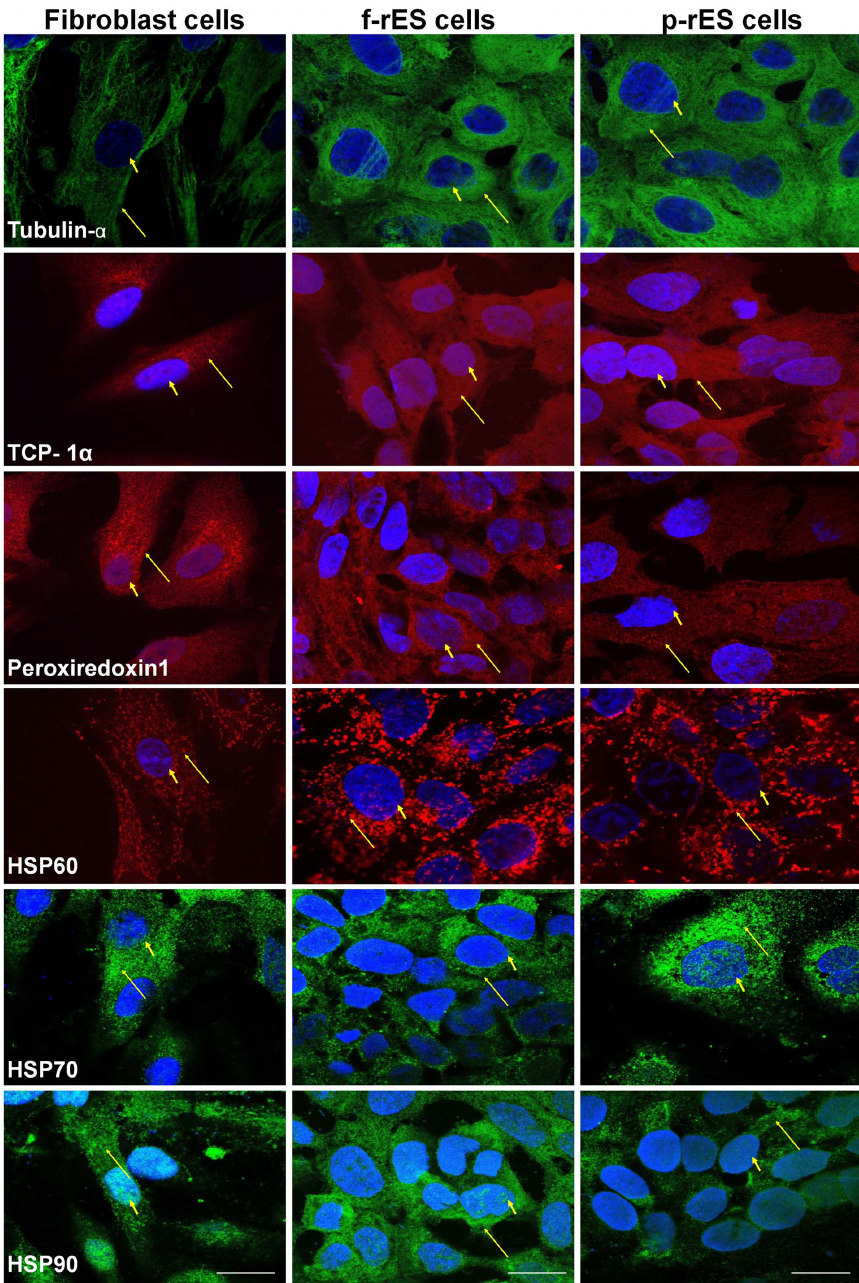
Figure 8. Immunocytochemical confirmation and subcellular localization of the selected proteins in fibroblast, f-rES, and p-rES cells. The cells were hybridized with primary antibodies against a -tubulin, peroxiredoxin 1, TCP-1 a , HSP60, HSP70, and HSP90 and then incubated with the secondary antibodies (Peroxiredoxin 1 and TCP-1 a , Alexa fluor 488-conjugated goat anti-mouse; a -tubulin, HSP60, HSP70 and HSP90, 546- conjugated goat anti-rabbit). The epifluorescent dye DAPI (1 m g/mL) was used for nuclear staining. The images were observed by confocal microscopy. Yellow arrows indicate protein locations in the cell, and arrow heads indicate the nucleus by DAPI staining. Bar=20 m m.